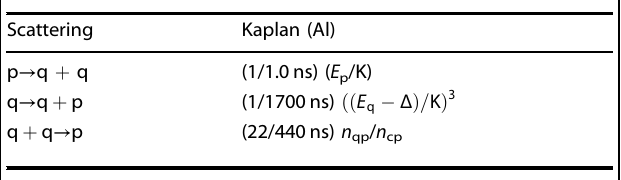
Table 1. Scattering processes.